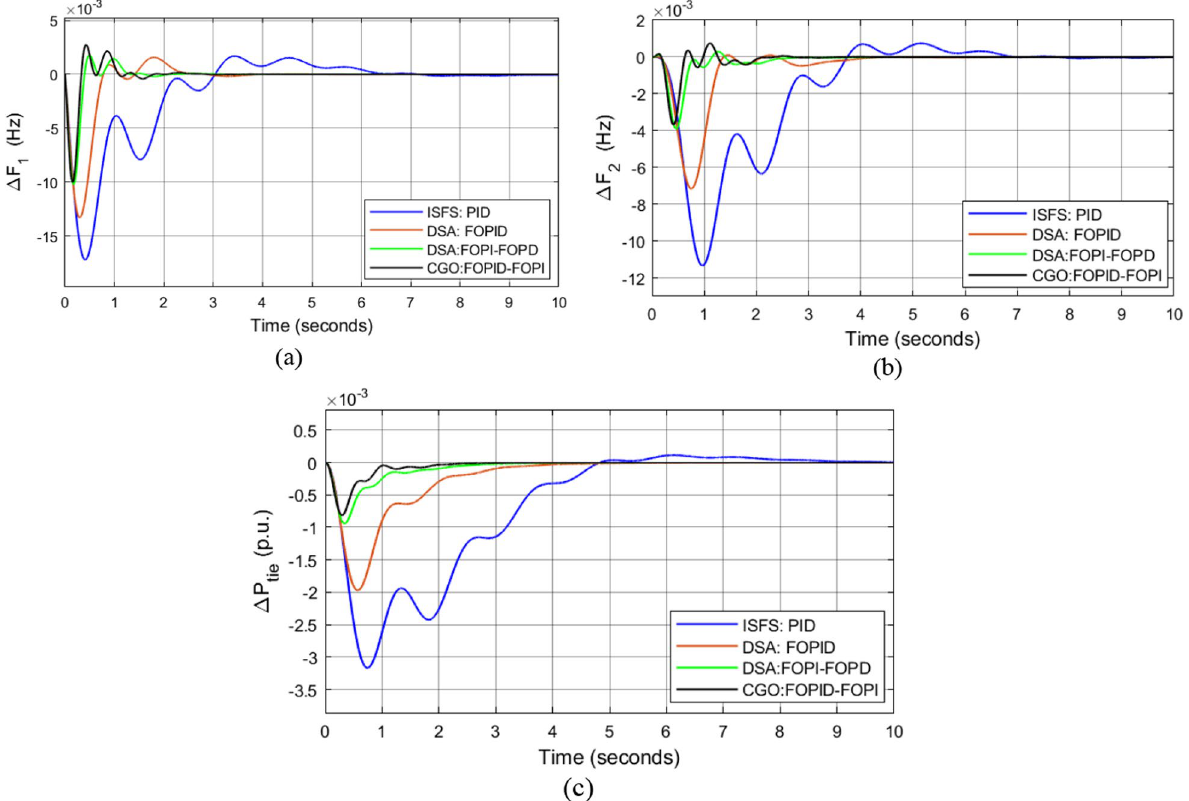
Fig. 12 Comparison of dynamic responses for Test-system 2 under 1% SLP in area 1: a ΔF 1 , b ΔF 2 , and c Δ P